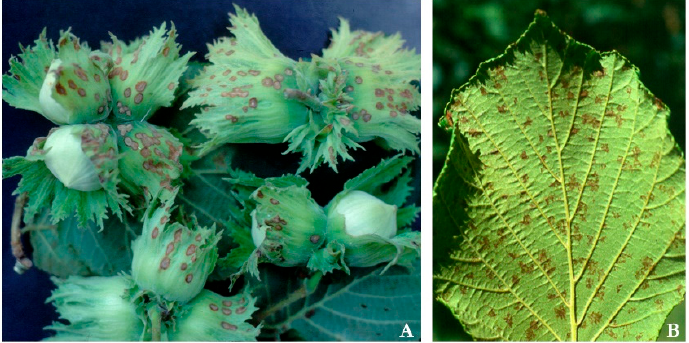
Figure 2. Typical symptoms induced by Xanthomonas arboricola pv. corylina on husks ( A ) and leaves ( B